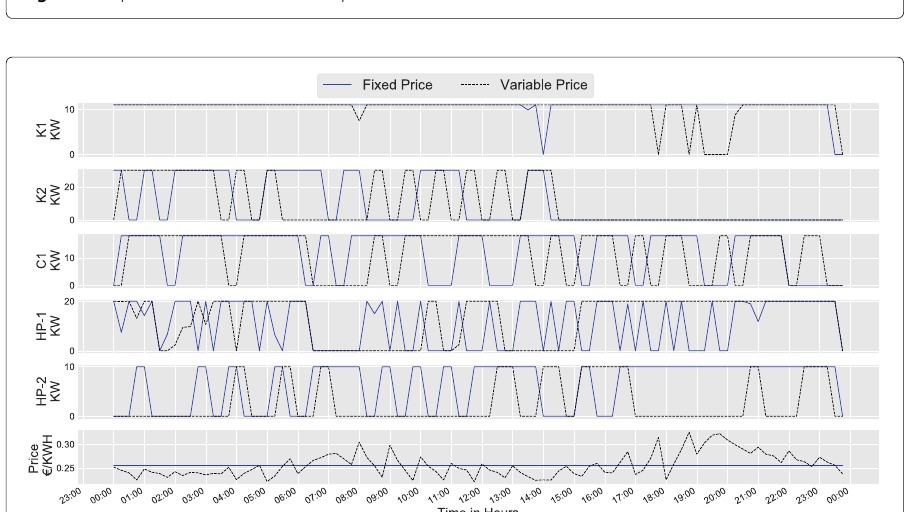
Fig. 6 Load profile of MFS with variable prices